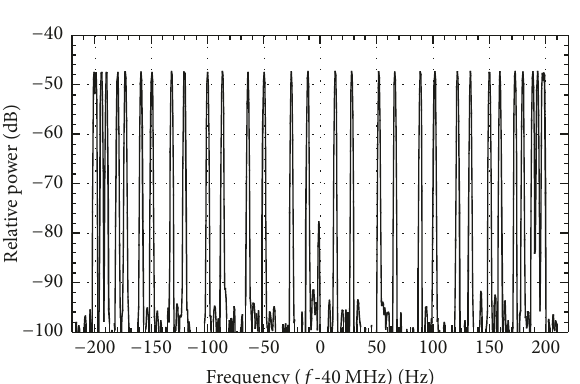
Figure 11: Doppler spectrum for 𝑀 = 𝑁 = 𝐾 = 1 with 𝑓 𝐷 = 200 Hz received by an omnidirectional